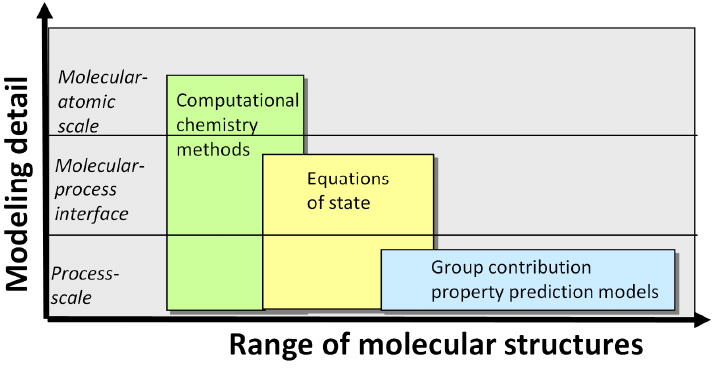
Figure 2. Property prediction models with respect to modeling detail and range of molecular structures which may be simulated at a reasonable computational